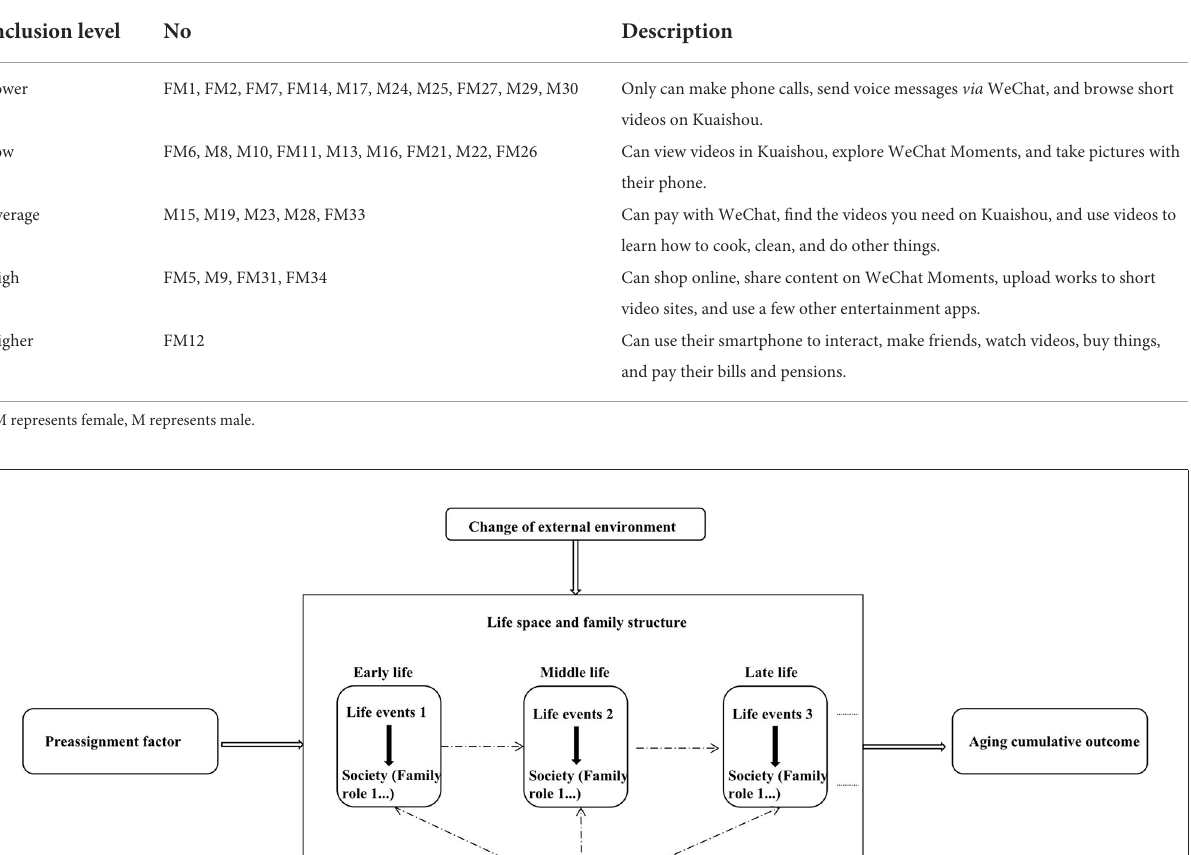
TABLE 2 Different levels of digital inclusion among rural elderly.